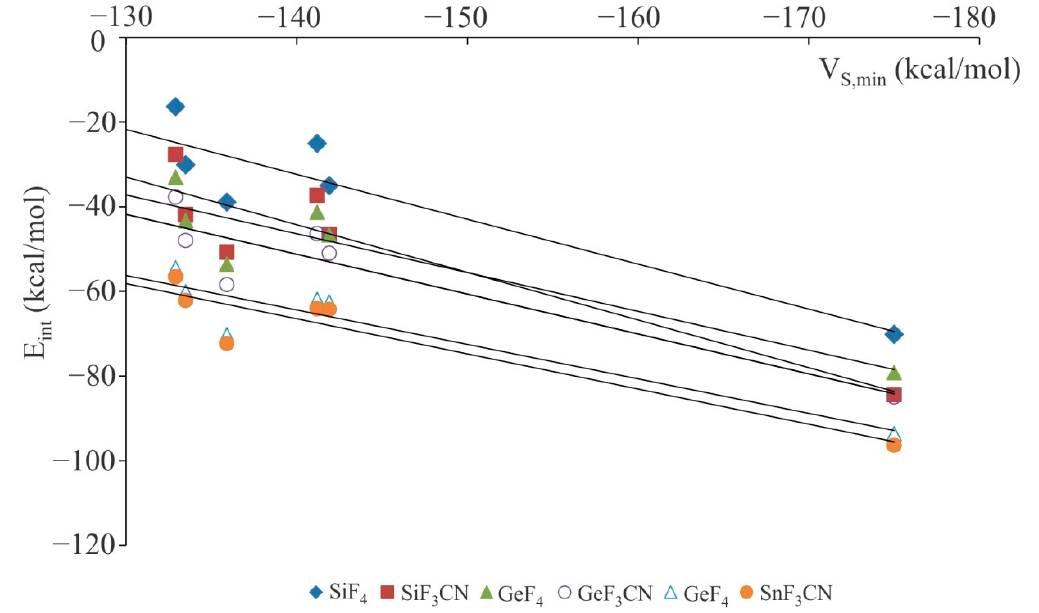
Figure 2. Correlation between the interaction energies and V S,min values associated with the A − anions in the binary XF 3 M:A − complexes. The squared correlation coefficient (R 2 ) value is 0.833, 0.831, 0.846, 0.839, 0.868 and 0.872 for SiF 4 , SiF 3 CN, GeF 4 , GeF 3 CN, SnF 4 and SnF 3 CN complexes, respectively.